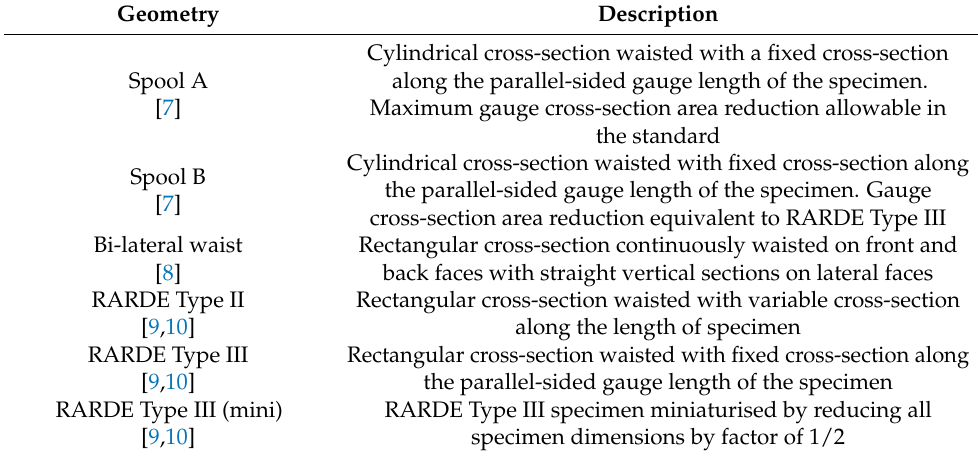
Table 2. Summary of direct test